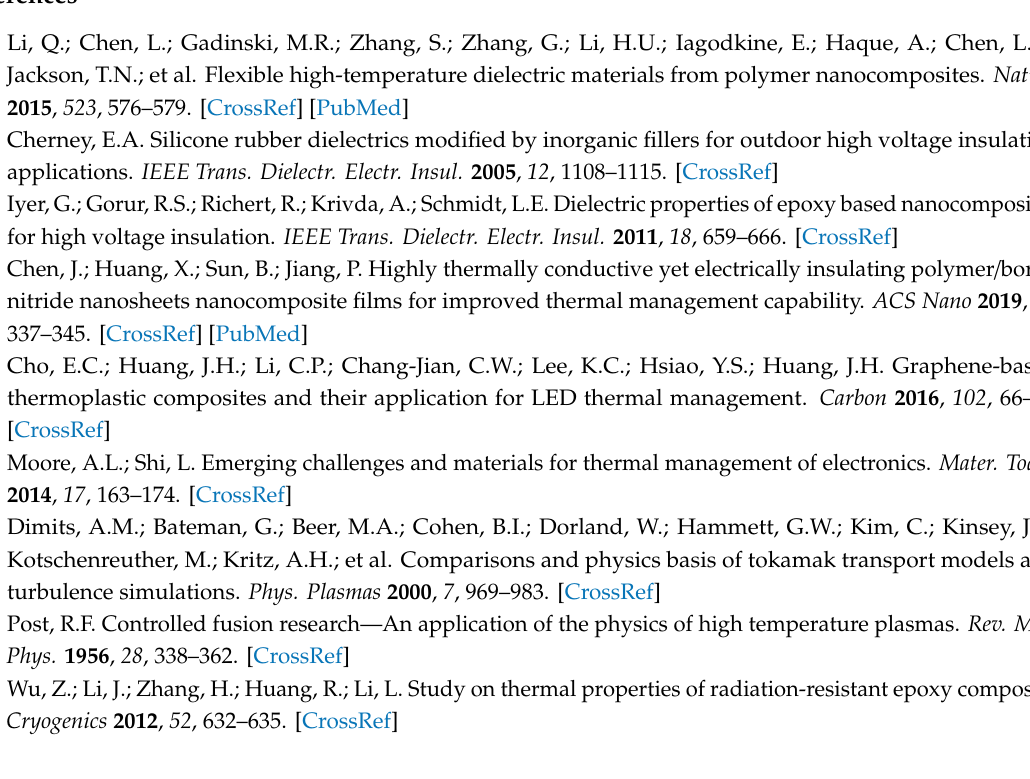
Figure S1: Fitted curves of the average CTE for epoxy / BNS composites as a function of